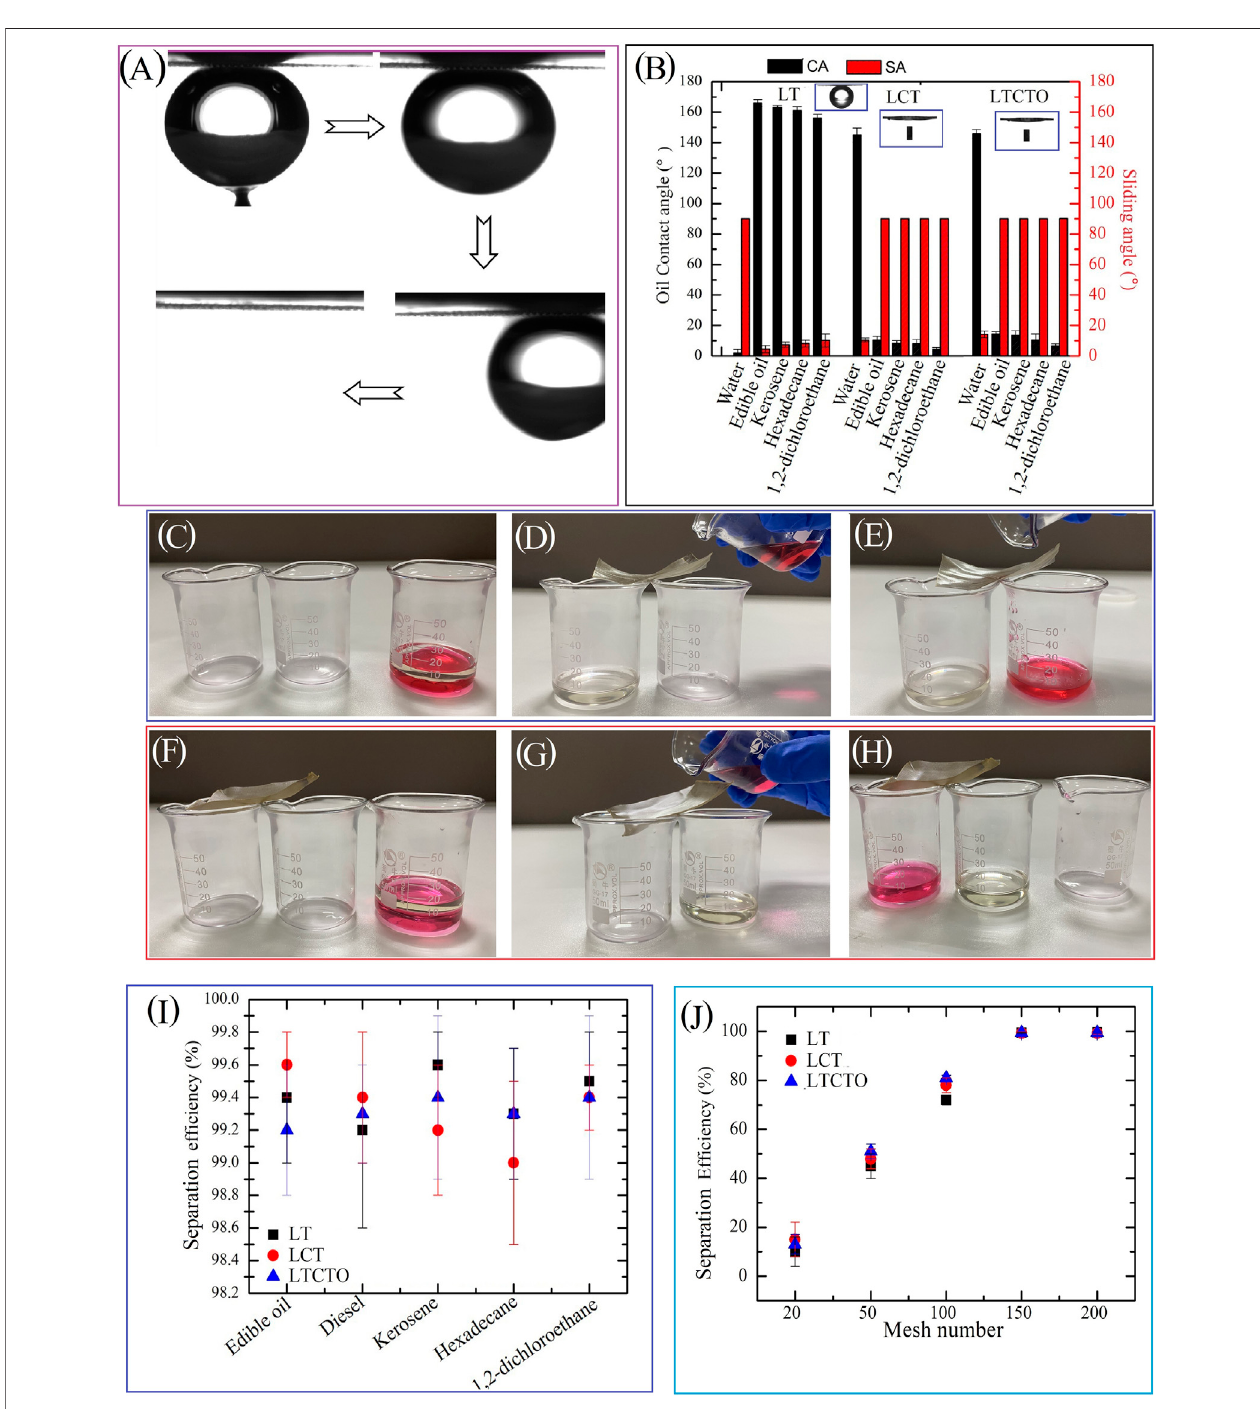
FIGURE5| Wettabilityandseparationef fi ciencyofthreedifferentpreparedmeshforvariousoilsandmeshnumbers, respectively. (A) Underwateroildropletrolling on the laser-treated copper mesh surface. (B) CA/SA as a function of various fl uid of sample after LT, LCT, and LTCTO. (C – H) Digital images for oil-water separation processingusingthecoppermeshafterLTandLTCTO (I) Separationef fi ciencyasafunctionofvariousoilsamplesafterLT,LCT,andLTCTO. (J) Separationef fi ciencyas a function of different mesh numbers of samples after LT, LCT, and LTCTO.